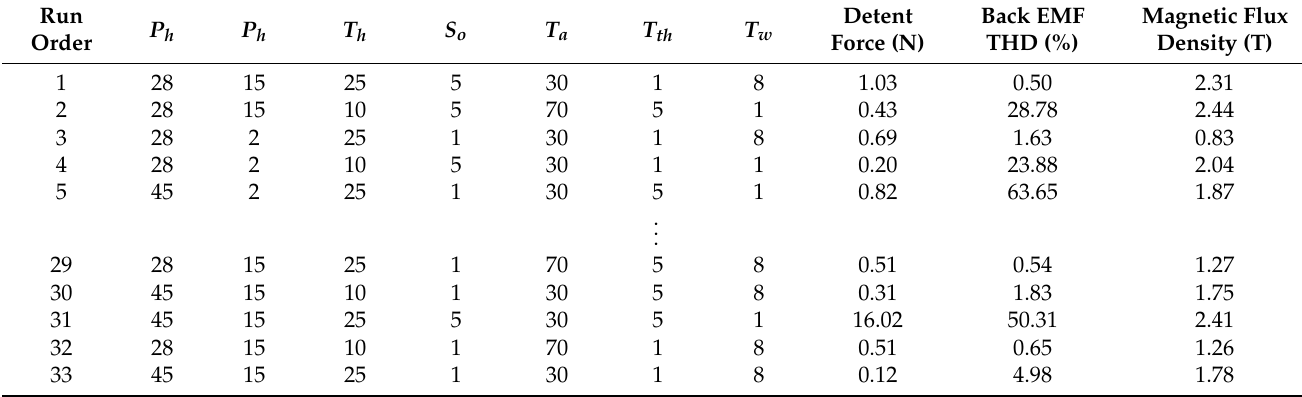
Table 3. Fractional factorial design and results.